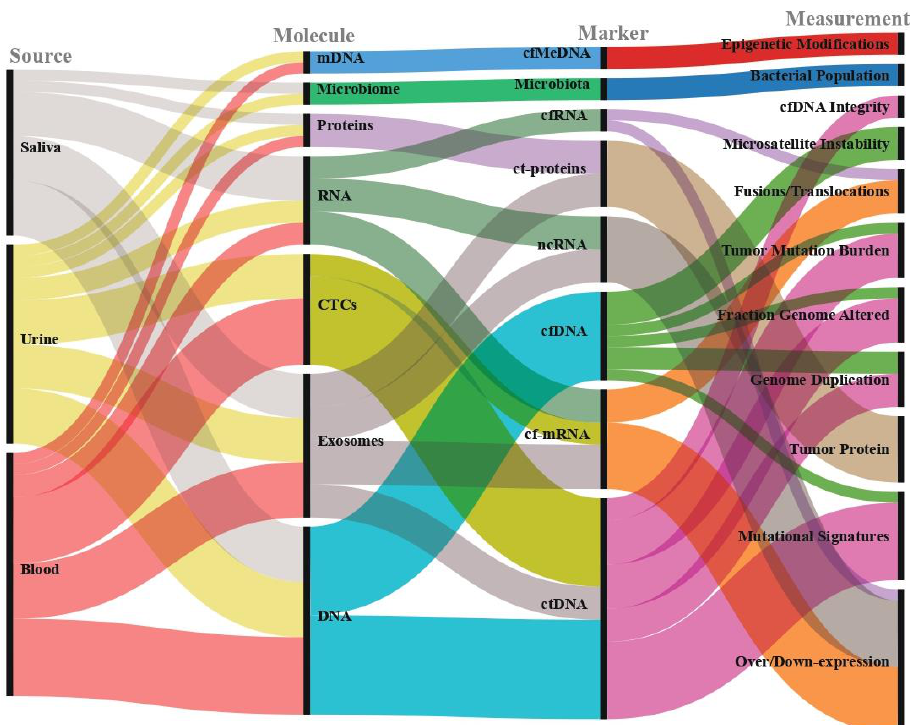
Figure 1. Visual representation of liquid biopsy applications through alluvial plot. The diagram flow shows the multitude of analytes (molecules) and applications (measurements) which can be assessed in liquid biopsy. To date, the evaluation of ctDNA in oncology is still limited to specific clinical indi- cations, such as the detection of actionable mutations in the bloodstream for a proper di- rectioning of targeted therapy, while no actual indication is currently approved for cell-